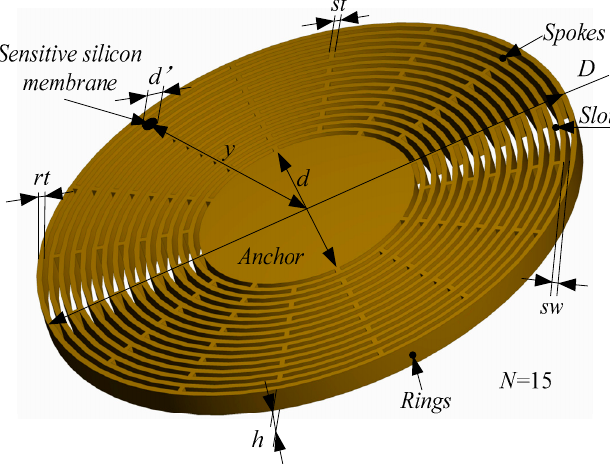
Figure 6. The structural schematic of the disc sensitive structure of MOEMS.